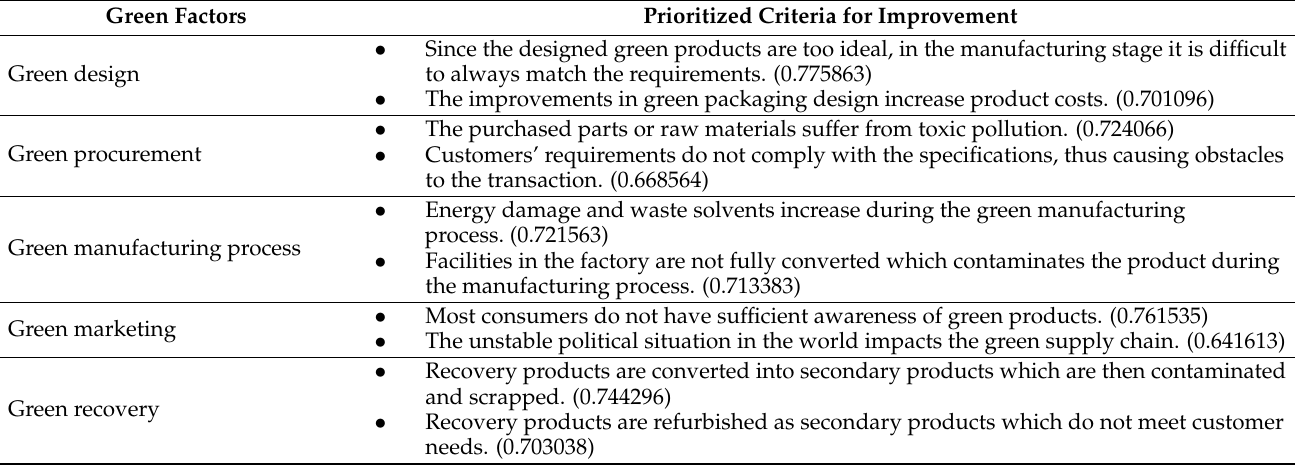
Table 10. The prioritized criteria for improvement works in each green